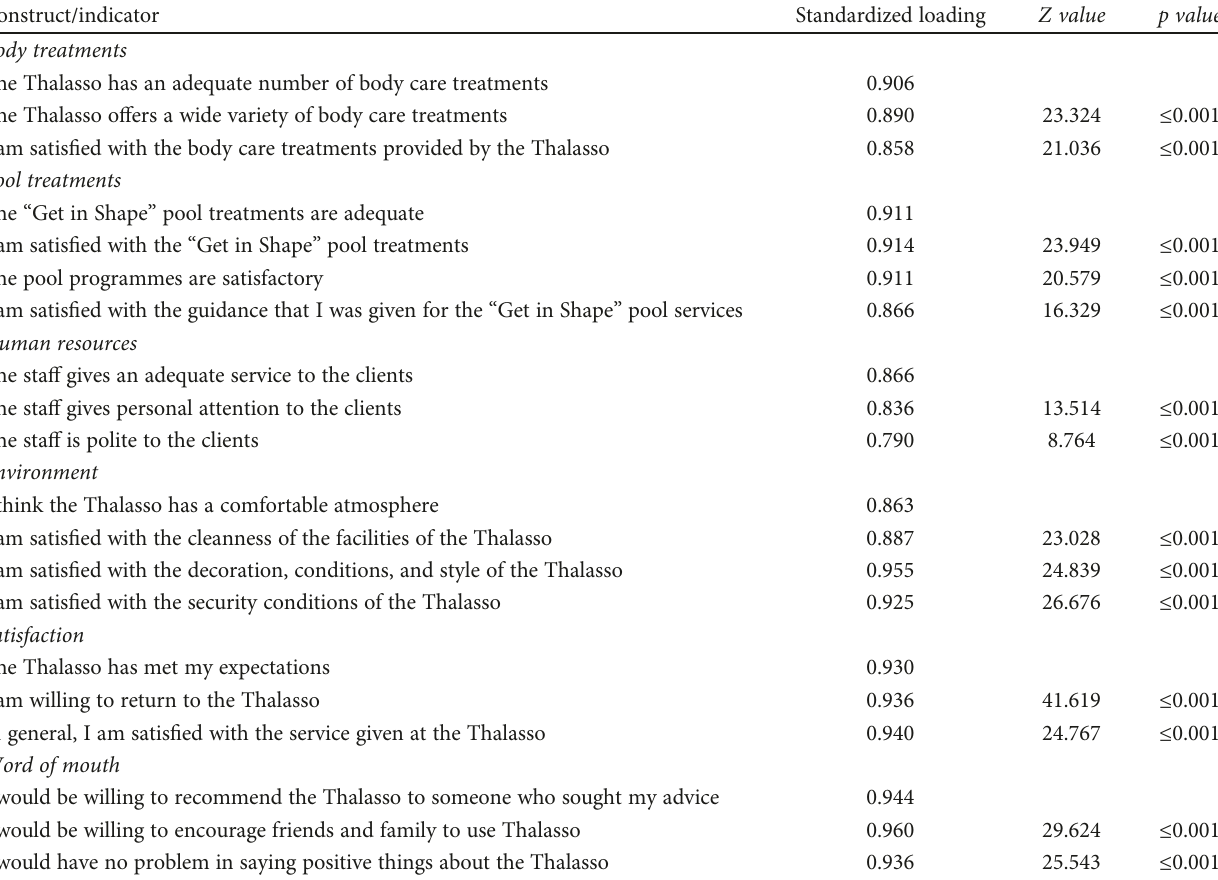
Table 3: Con fi rmatory analyses.